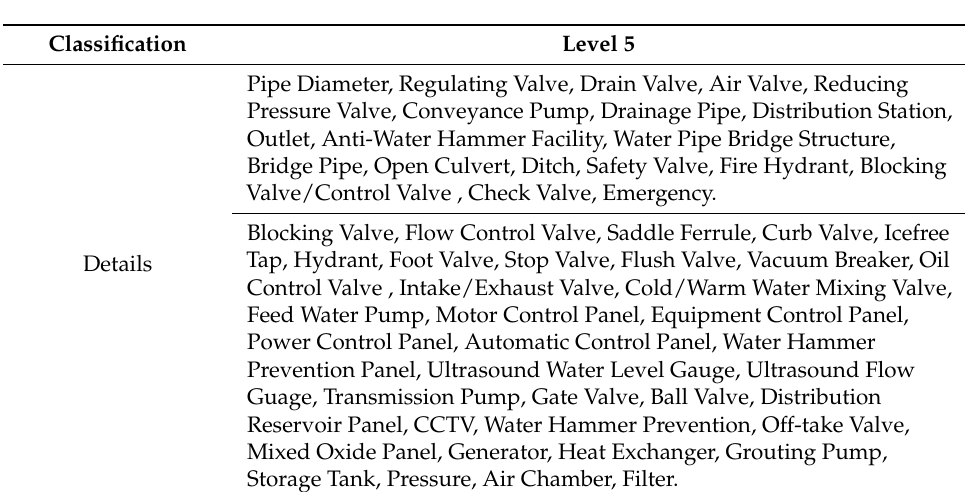
Table 7. Inventory composition of Level 5.